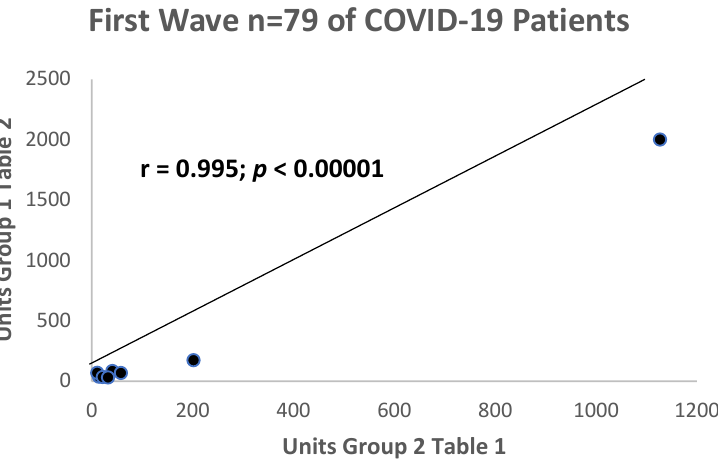
Figure 2. Scattergram of comparable clinical parameters in the current COVID-19 cumulative cohort versus the same parameters in the first wave of COVID-19 patients from the same medical center.